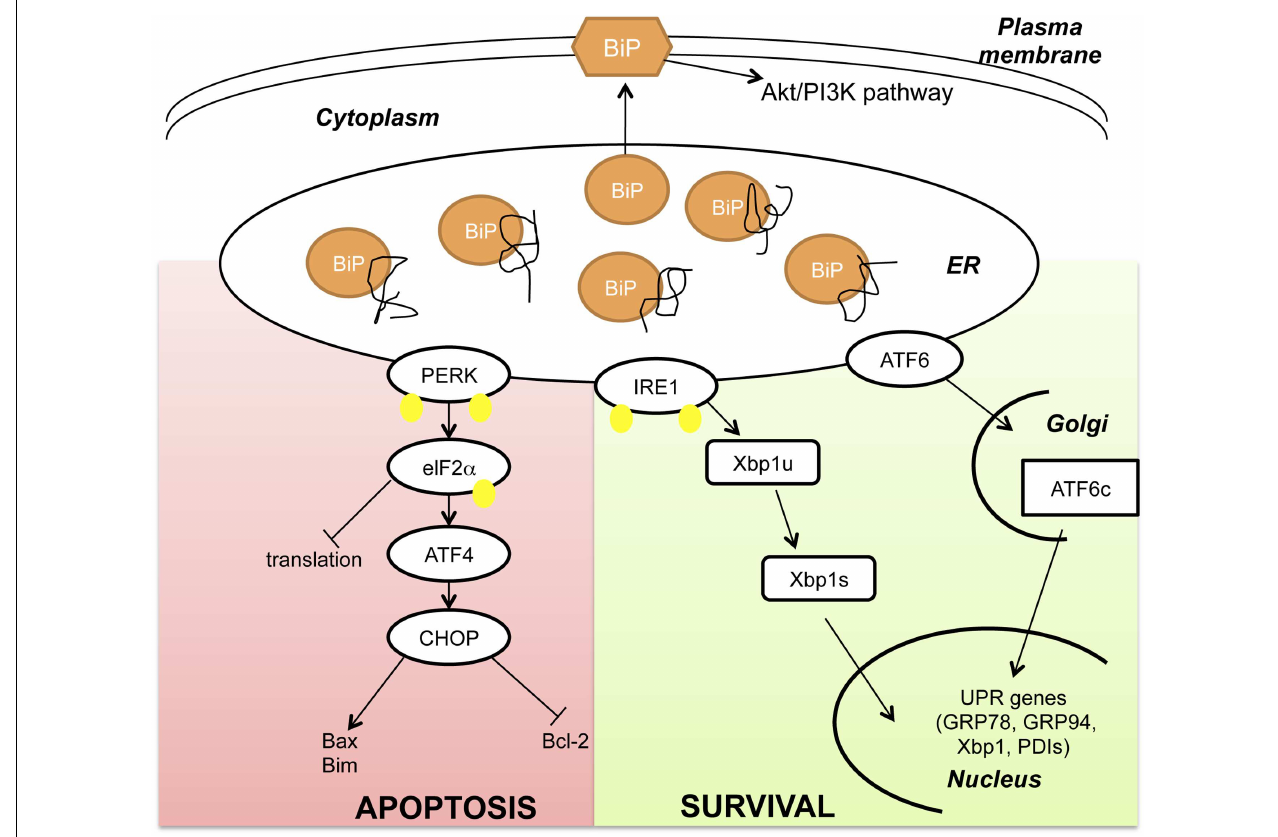
PERK, the kinase/endonuclease IRE1 homodimerizes and autophosphorylates before splicing Xbp1 mRNA (Xbp1u: Xbp1 unspliced; Xbp1s: Xbp1 spliced).The third branch of the UPR is activated after cleavage of the transcription factor ATF6 in the Golgi (cATF6). Both cATF6 and Xbp1s regulate transcription of pro-survival genes like Glucose Regulated Proteins 78 and 94 (GRP78 and 94) and Protein Disulfide Isomerases (PDIs). In addition to its canonical function in the ER, it has also been shown that BiP can localize to the plasma membrane and regulate the Akt/PI3K pathway. (Yellow dots indicate phosphorylation. For simplicity PERK and IRE1 are shown as